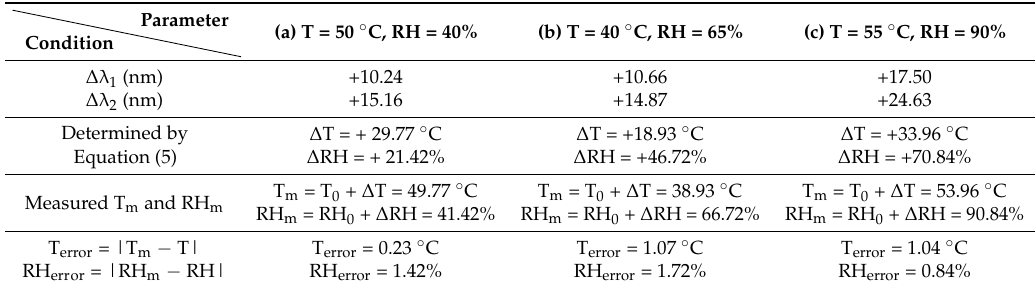
Figure 7. (1) and (2) are interference spectra shifts of sensor 1 and sensor 2 , respectively, when RH and T change simultaneously in Conditions ( a – c ). Table 1. Evaluating the simultaneous measurement of T and RH variations in different conditions of the proposed sensor.